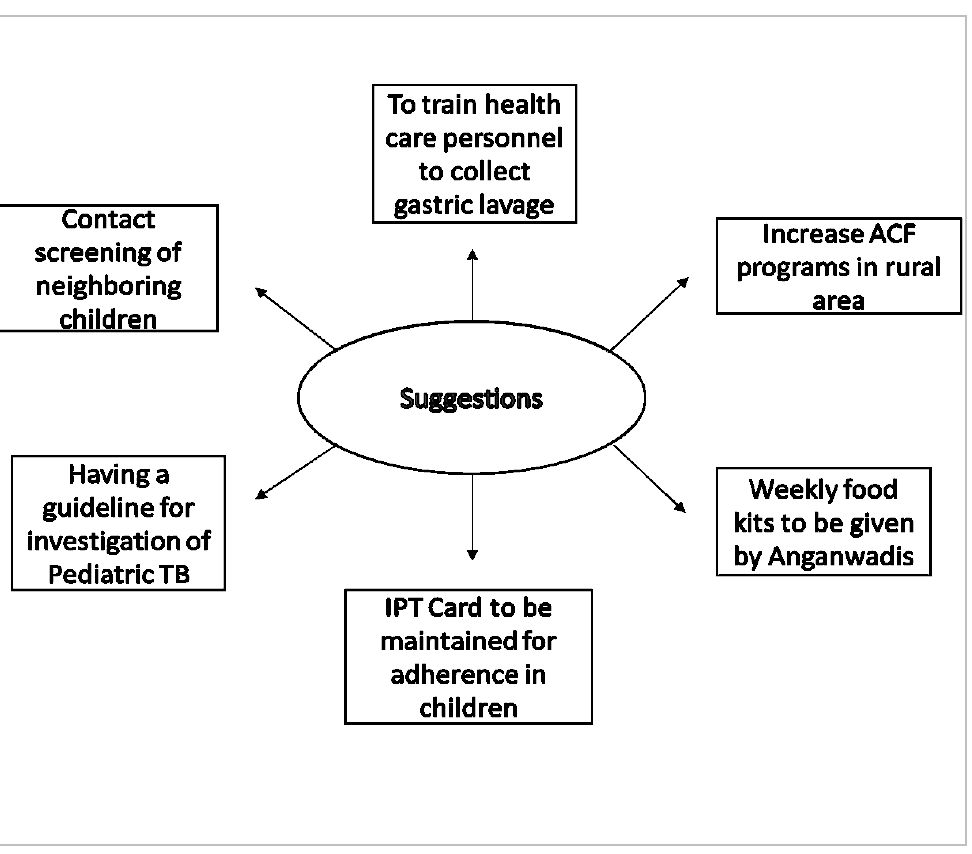
Figure 3. Depicting the key suggestions to improve contact screening and IPT initiation in children.